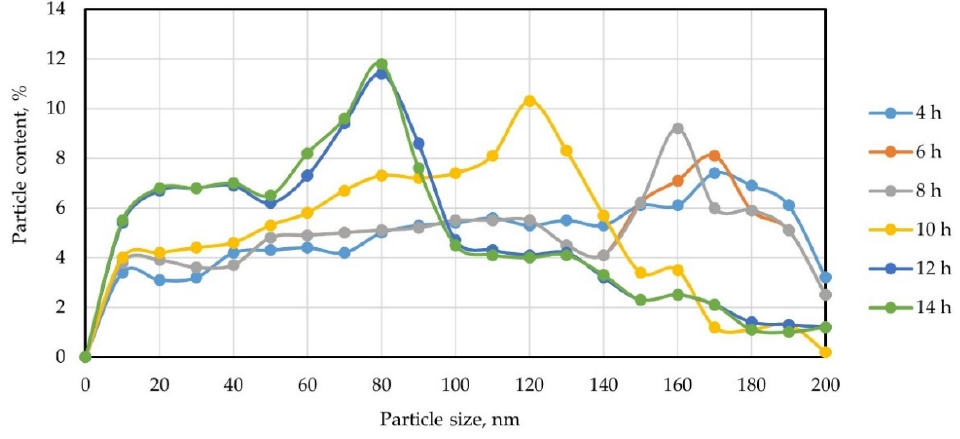
Figure 3. Size distribution of nanosilica particles at different grinding times.